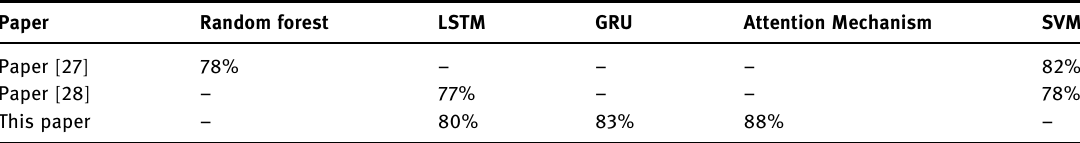
Table 2: Comparing algorithm among the binary - class